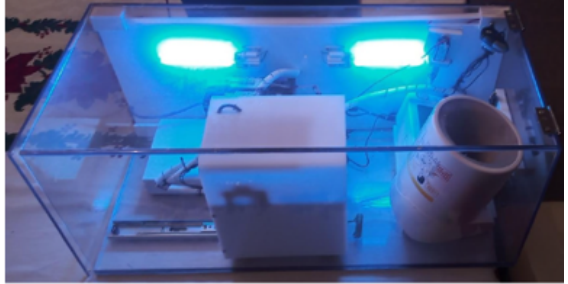
Figure 3. Version B with UV-C